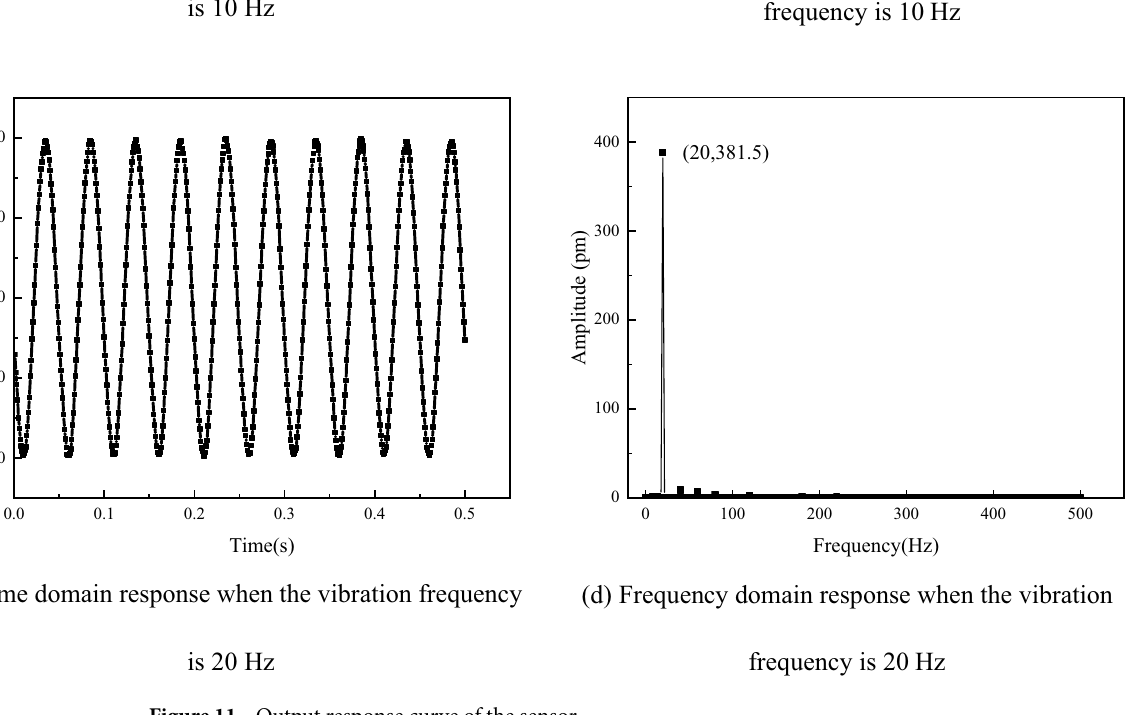
Figure 11. Output response curve of the